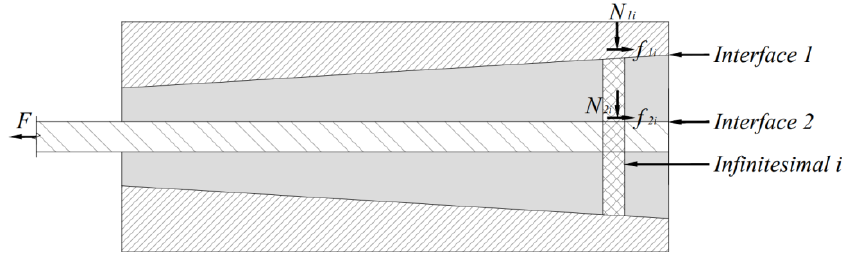
Figure 2. Stress analysis for composite anchorage device.